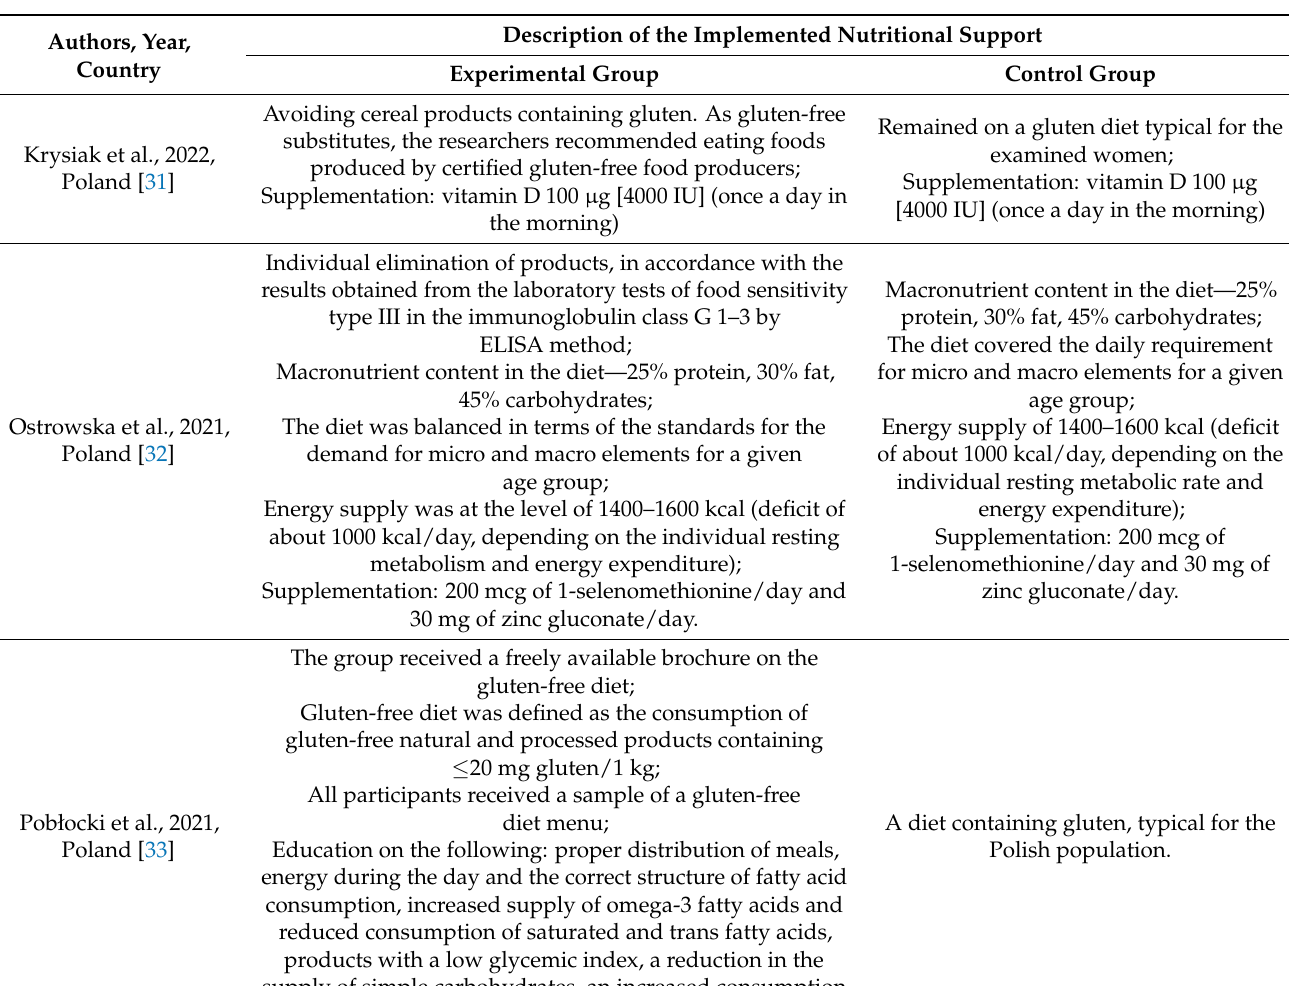
Table 3. Description of the implemented nutritional/dietary